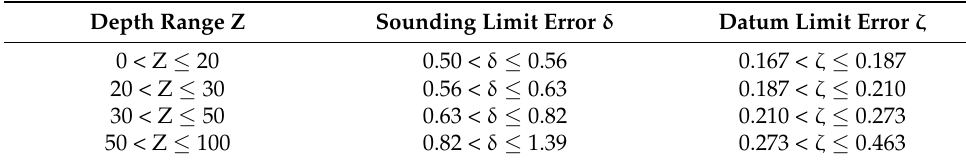
Table 1. Datum accuracy requirements (confidence 95 %) (unit: